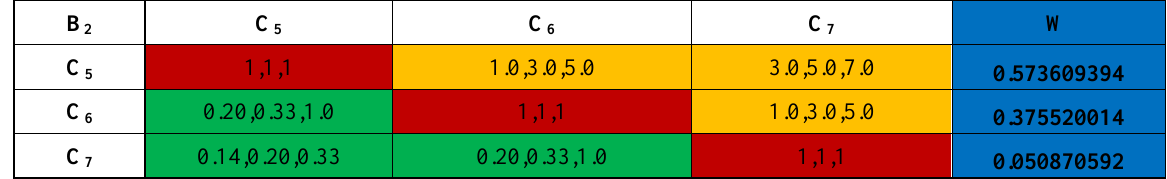
Table 6. The pairwise comparison matrix, B